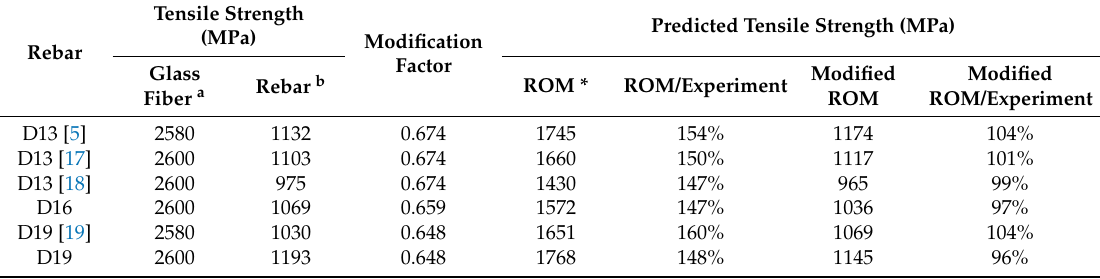
Table 5. Comparison of tensile strengths predicted by conventional ROM and modified ROM using Equations